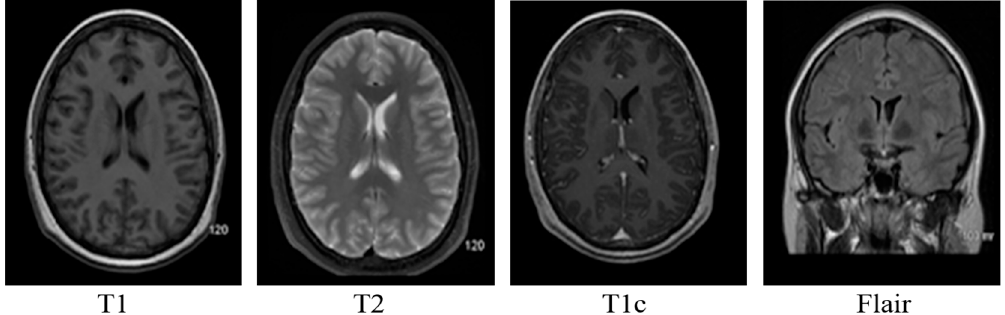
Figure 3. Pictorial view of brain MR Image modalities.